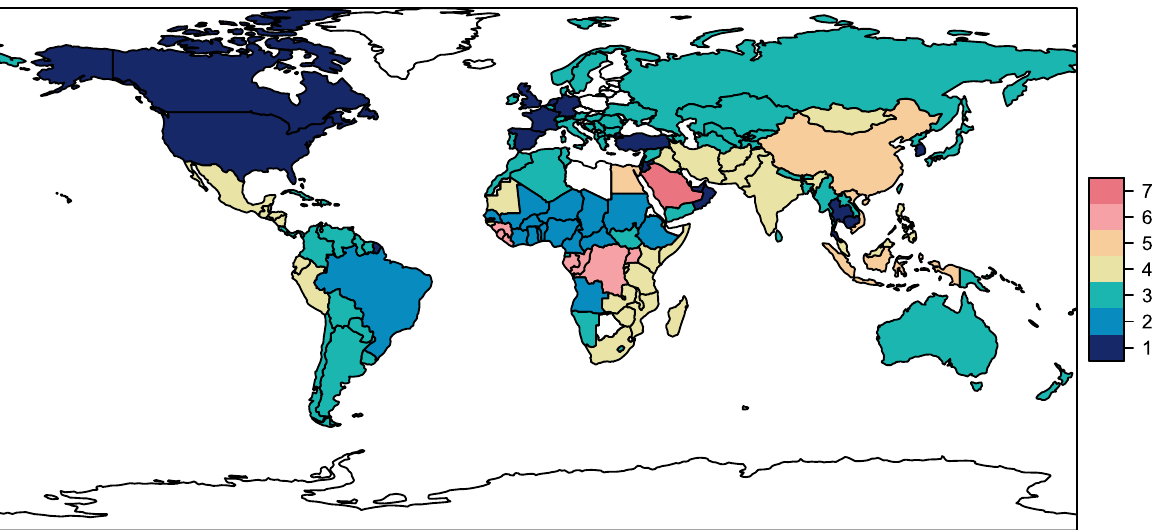
Fig 4. Which countries report more similar kinds of outbreaks? Seven clusters are mapped (each a different color) based on an unsupervised clustering algorithm (k-means). Base map generated by R package ‘rnaturalearth’ using Natural Earth data compatible with CC BY 4.0 license.